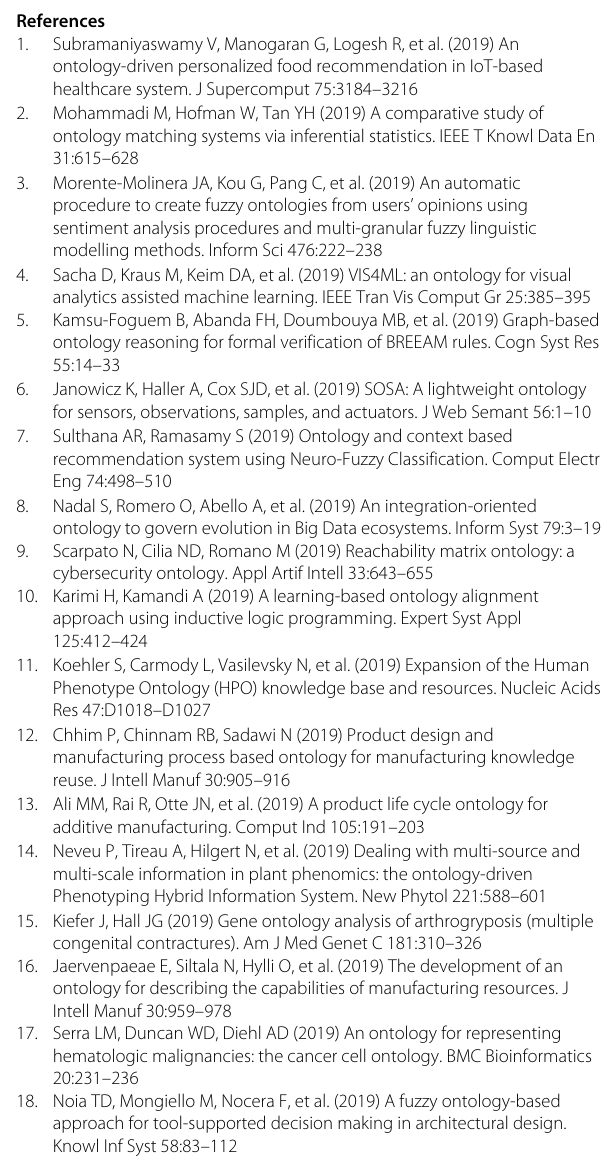
P@1 data P@3 data P@5